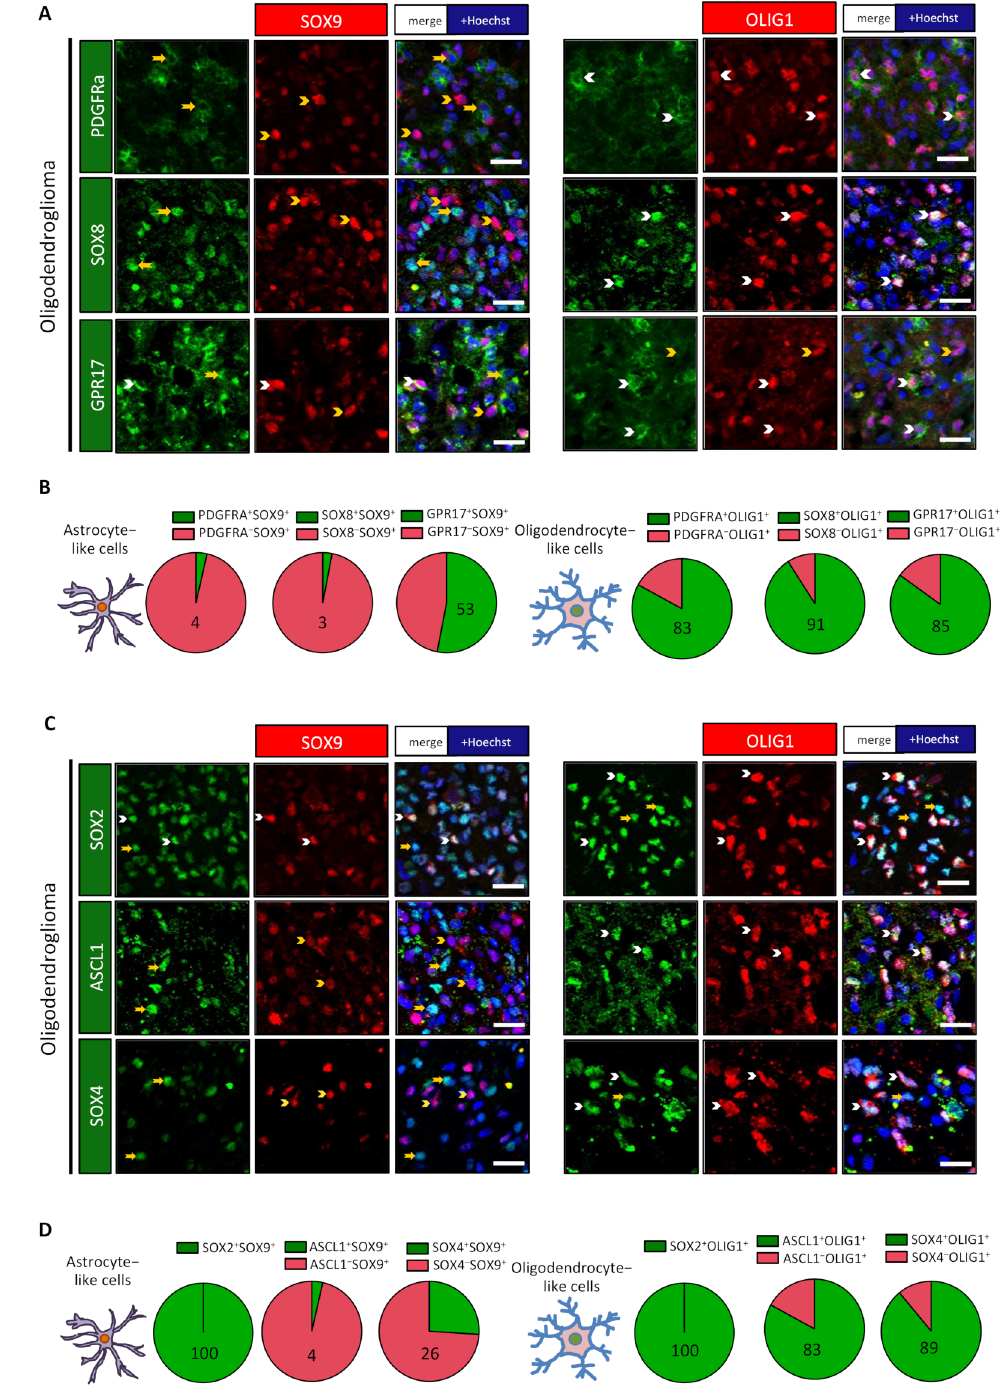
Figure 2. OLIG1 + cells express proteins associated with oligodendrocyte lineage and neural precursor cells. Double immunoflu- orescences for indicated proteins on one oligodendroglioma. White arrowheads identify double-positive cells, while yellow arrowheads/arrows represent single-positive cells. Scale bars = 20 µ m. ( A ) Double stainings for GPR17, PDGFR α , and SOX8 with SOX9 or OLIG1 revealed their preferential association with OLIG1 + cells in one oligodendroglioma. ( B , D ) Pie diagrams representing the percentage of double-positive (green) and single-positive (red) cells in SOX9 + and OLIG1 + populations. Numbers indicate the percentage of double-positive cells. ( C ) Double stainings for ASCL1, SOX2, and SOX4 with SOX9 or OLIG1 revealed the preferential association of ASCL1 and SOX4 with OLIG1 + cells in one oligodendroglioma, while SOX2 was expressed by both